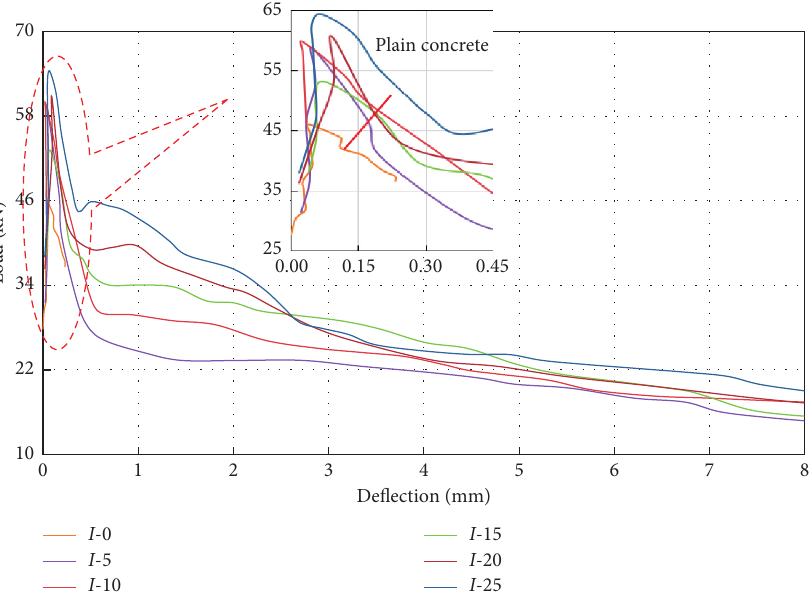
Figure 6: The load-deflection curves of industrial steel fiber reinforced concrete. Table 7: Flexural toughness index and residual strength coefficient of steel fiber reinforced concrete. Flexural toughness Type No.